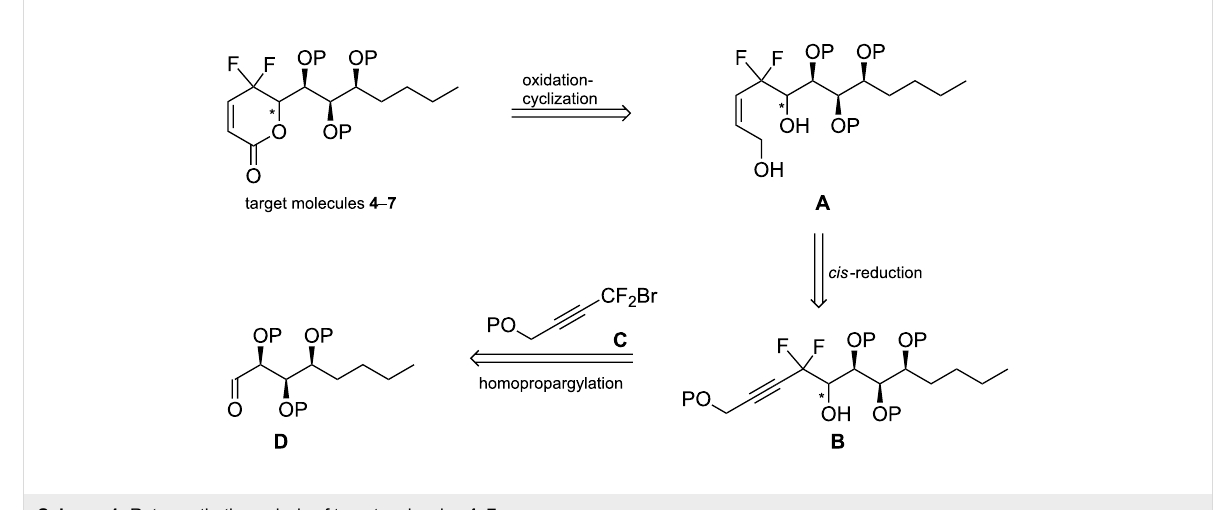
Scheme 1: Retrosynthetic analysis of target molecules 4 – 7 .